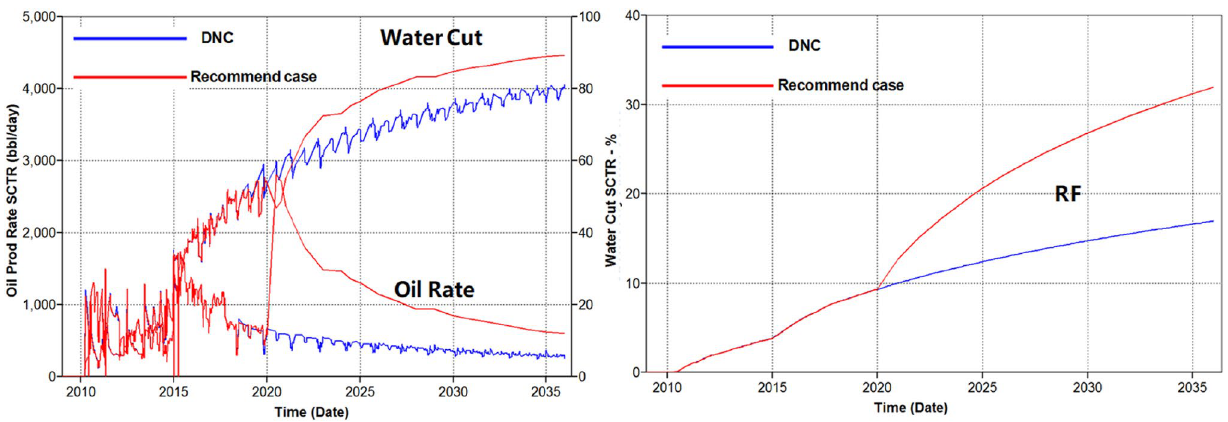
Fig. 16 Oil rate, water cut and recovery factor curve of recommended